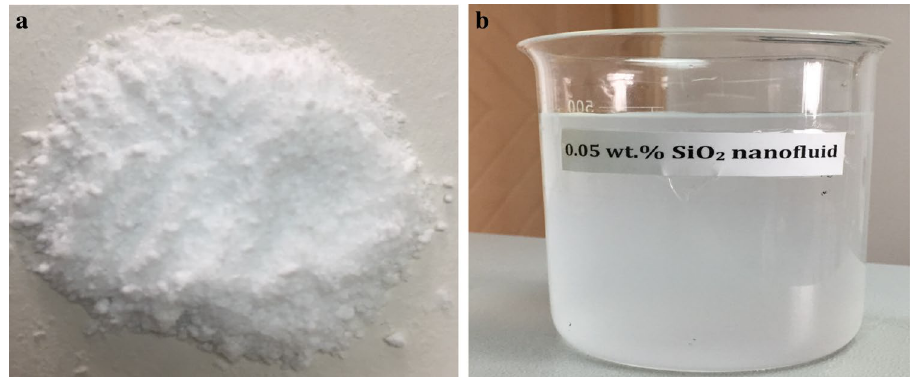
Fig. 1 a SiO 2 nanoparticles and b 0.05 wt.% SiO 2